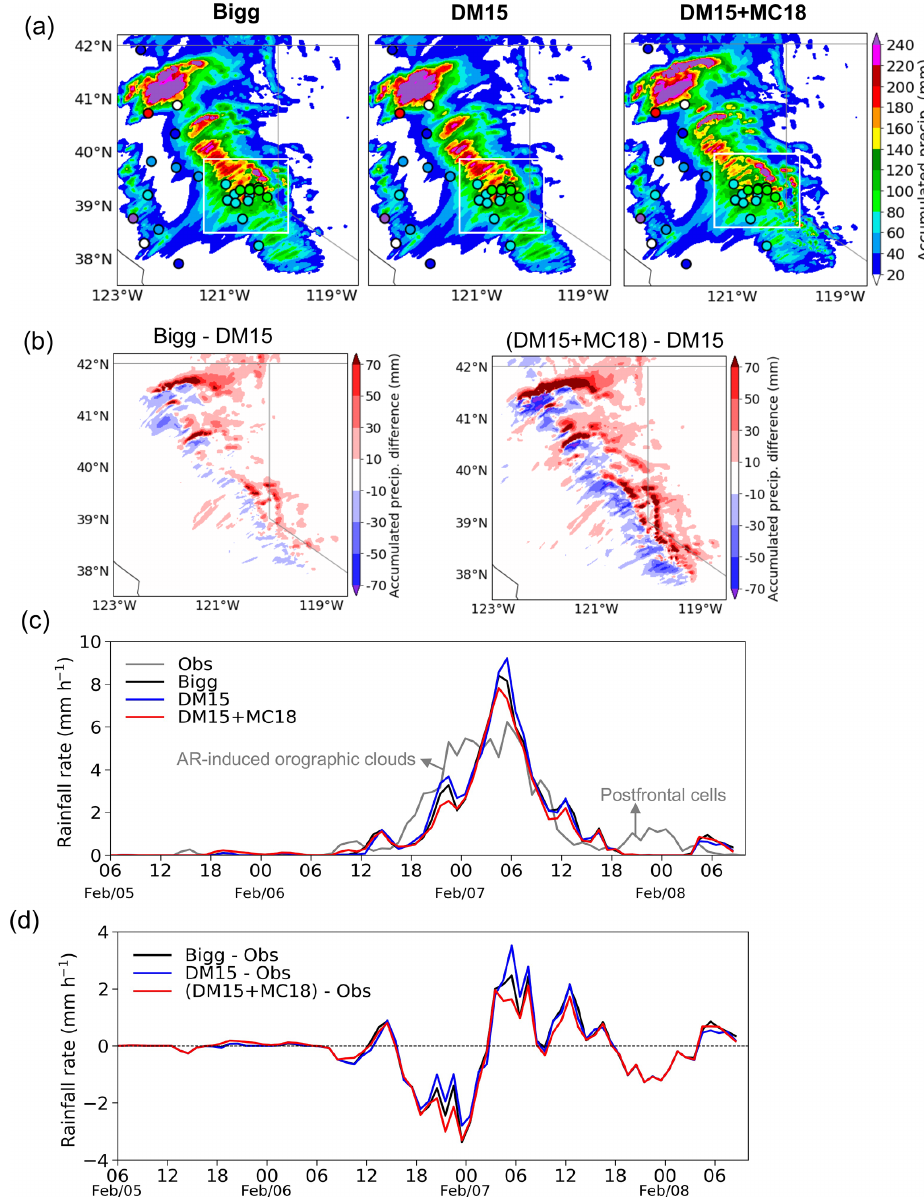
Figure 4. (a) Spatial distributions of accumulated precipitation during the AR event (5 February 06:00 to 8 February 09:00 UTC) from Bigg, DM15, and DM15 + MC18. The color shading is for simulations and the circles denote the rain gauge measurements provided by NOAA Physical Sciences Laboratory. (b) The same as (a) but for differences between Bigg and DM15 (left) and between DM15 + MC18 and DM15 (right). (c) Time series of precipitation rates during the entire AR event for rain gauge observations (gray line), Bigg (black line), DM15 (blue line), and DM15 + MC18 (red line). (d) Differences between the simulations and observations based on the data of (b) . The precipitation rates in (b) are averaged over all the rain gauge sites shown in (a) . The white boxes in (a) mark the region where the precipitation simulation is improved by adding marine